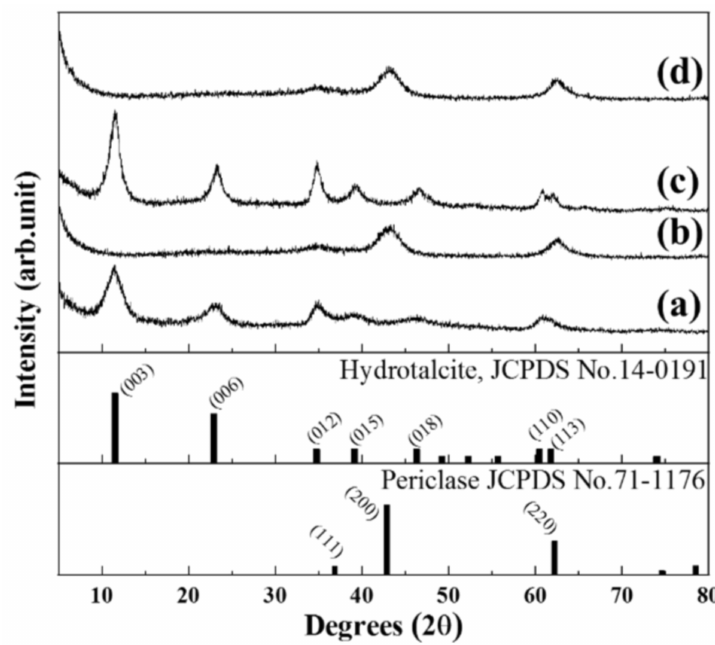
Figure 2. XRD patterns of ( a ) AH-1, ( b ) AO-1, ( c ) AH-2, and ( d ) AO-2. Joint Committee of Powder Diffraction Standards (JCPDS) No. 14-0191 and 71-1176 stand for hydrotalcite and periclase phases, respectively. Hydrotalcite is a mineral name of naturally found Mg 3 Al(OH) 8 (CO 3 ) 0.5 -LDH. Periclase is a mineral name of MgO, which is the major component of calcined MgAl-LDH. Calcined LDHs, AO-1 and AO-2, were determined to have periclase (MgO) phase (JCPDS No.71-1176), exhibiting diffraction peaks at 2 θ of 34.53 ◦ , 43.12 ◦ , and 62.52 ◦ for